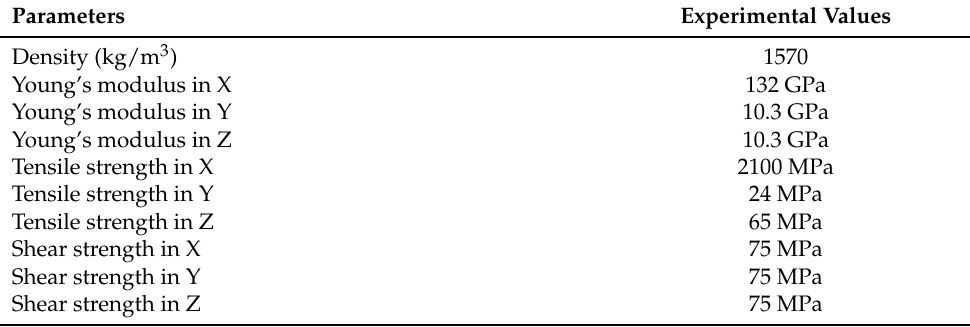
Table 2. Material properties of T700 carbon fiber/epoxy (Data acquired from [16]). Parameters Experimental Values Density (kg/m 3